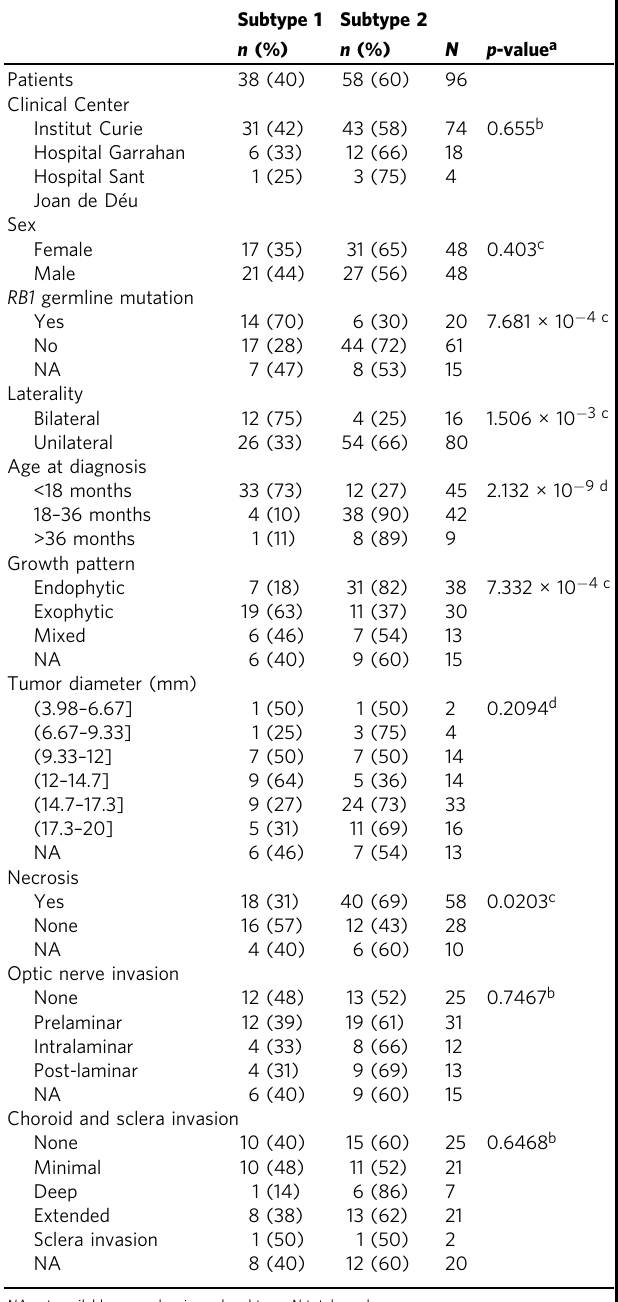
Table 1 Clinical and histopathological characteristics of patients strati fi ed by molecular